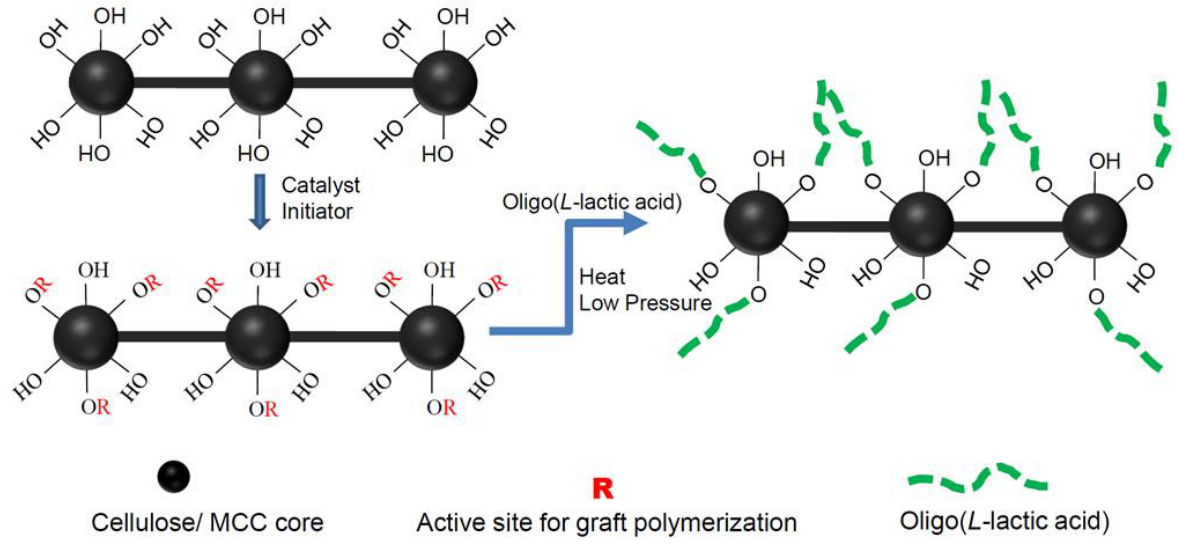
Figure 2. Structural representation of grafting of α -cellulose or MCC with oligo ( L -lactic